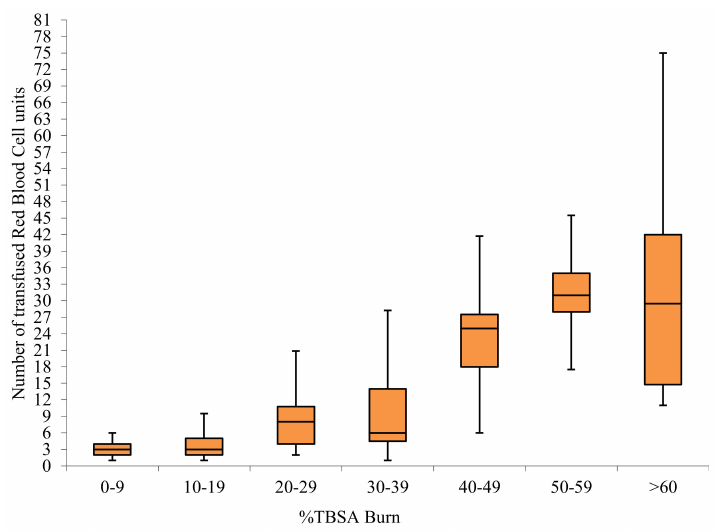
Figure 1. Red blood cell usage by TBSA in transfused surgical patients.